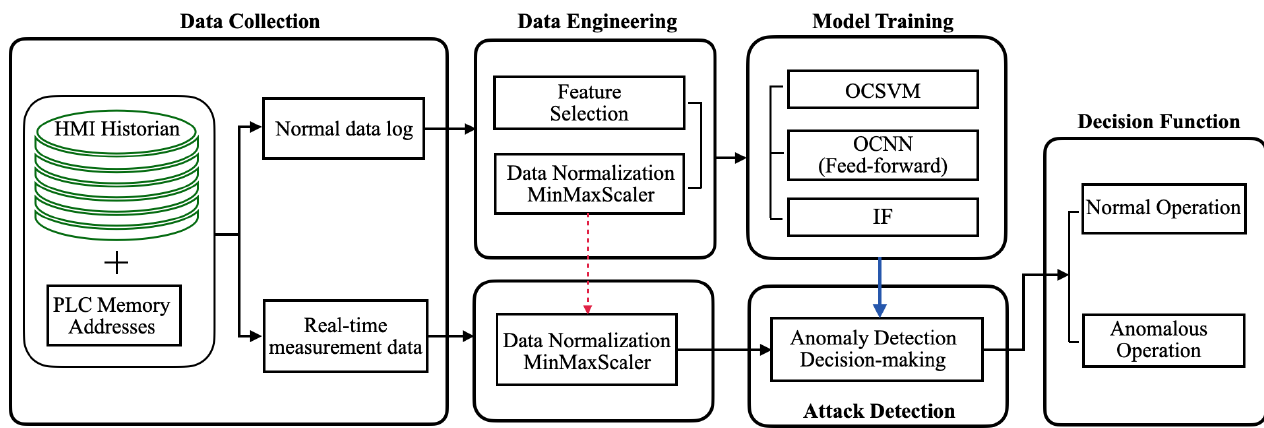
Figure 4. General framework of the anomaly detection